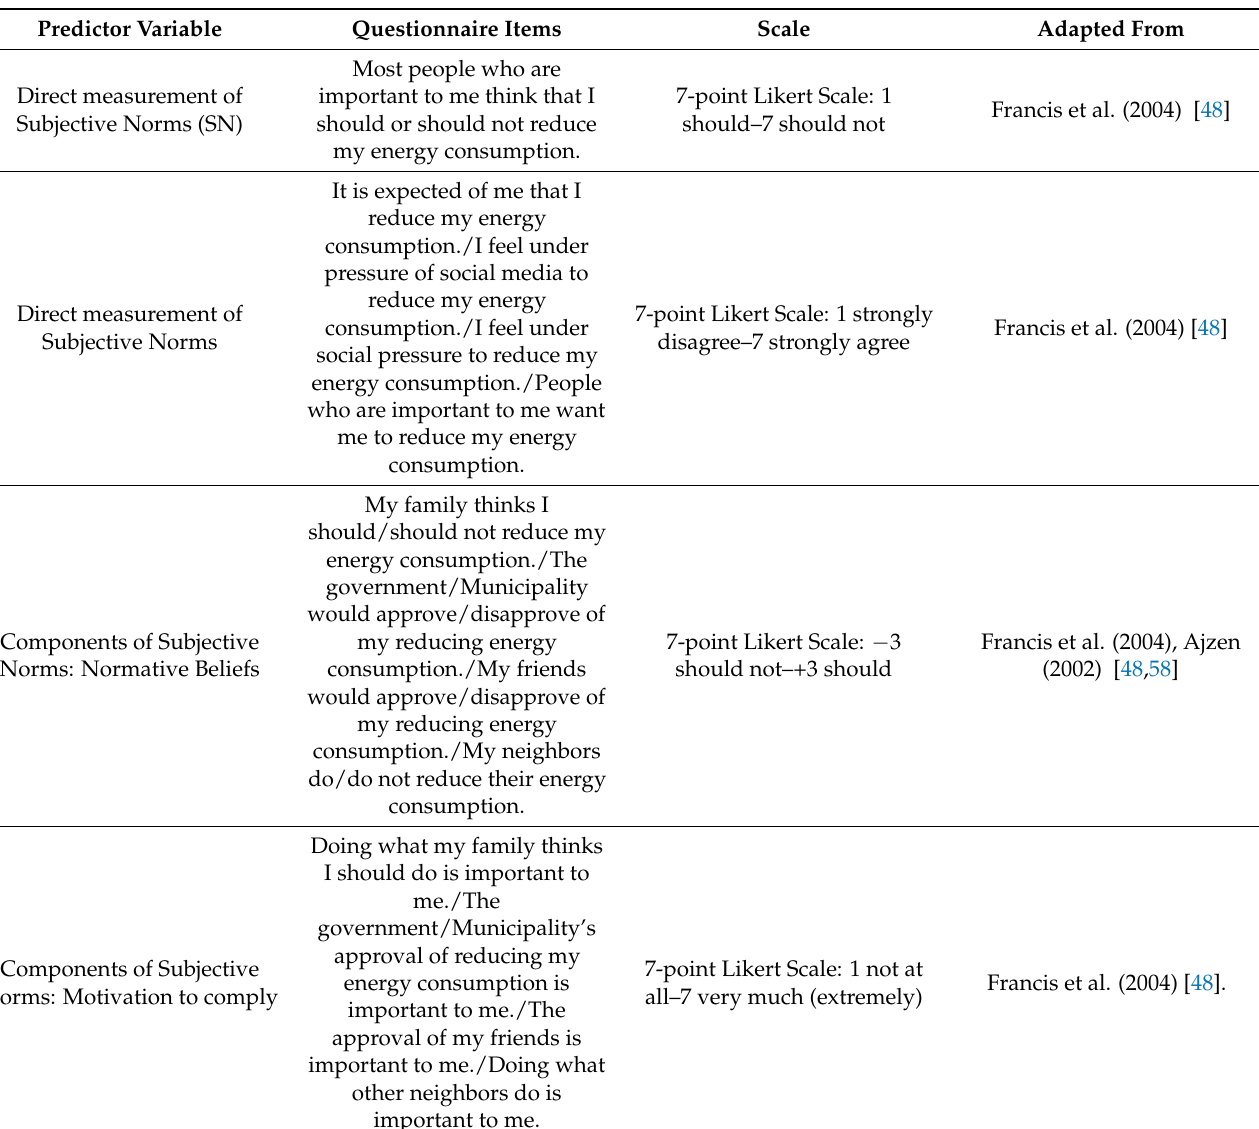
Table 3. Subjective Norms (the table was created by using resource of Ajzen and Fishbein (2005)